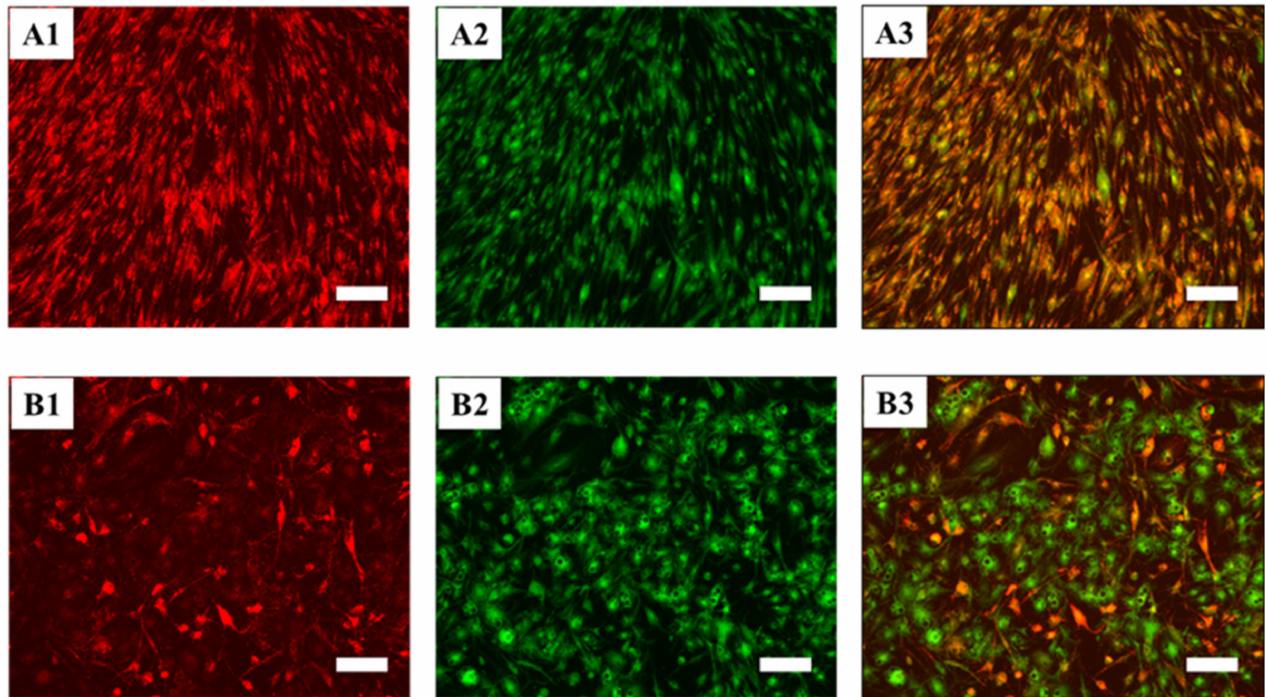
Figure 8. JC-10 staining shows mitochondrial depolarization after culturing confluent hASCs in the US-BAT medium. ( A1 – A3 ) Negative control: not induced hASC, grown on UrSuppe basal medium. ( B1 – B3 ) BAT induction, green fluorescence: changes of the membrane potential (caused by UCP1 expression). ( 1 ) Representative microphotograph taken with a 590 nm filter showing JC-10 aggregates in normal cells. ( 2 ) Representative microphotograph taken with a 525 nm filter showing JC-10 monomer in depolarized mitochondria. ( 3 ) Merged. Fold magnification 100 × . Scale bar 150 µ